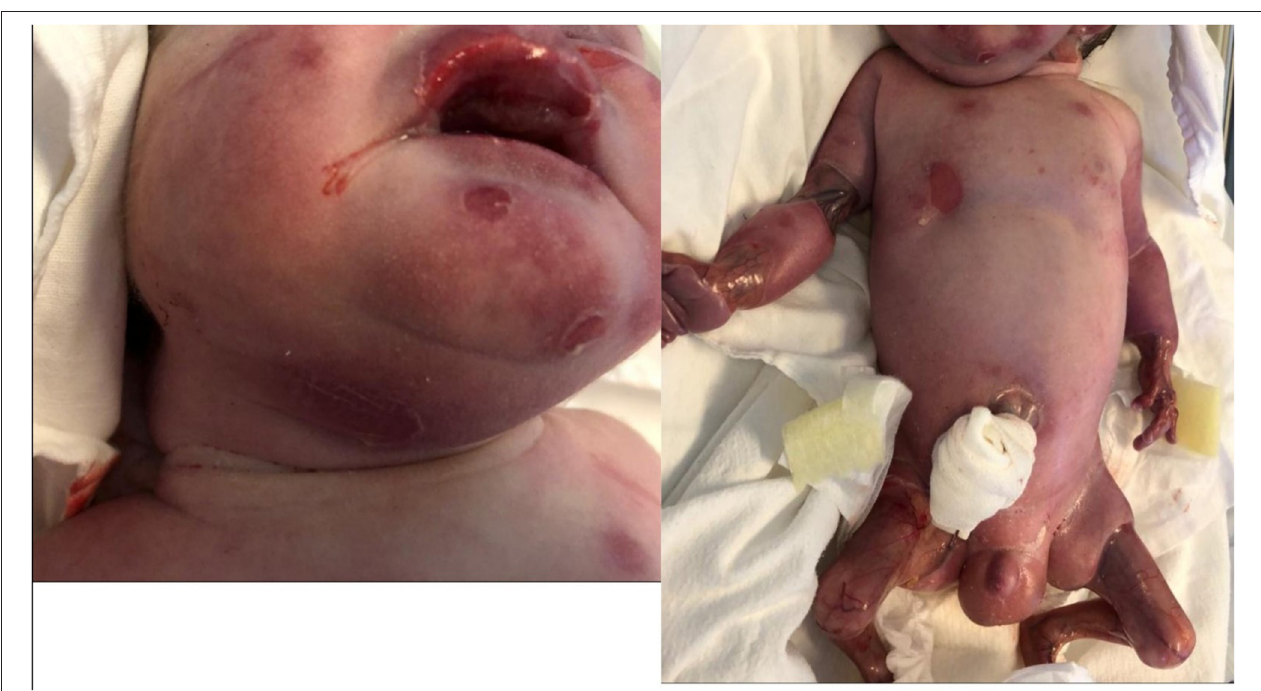
FIGURE 3 | Bullous lesions on face and trunk. Small zones of aplasia cutis on upper